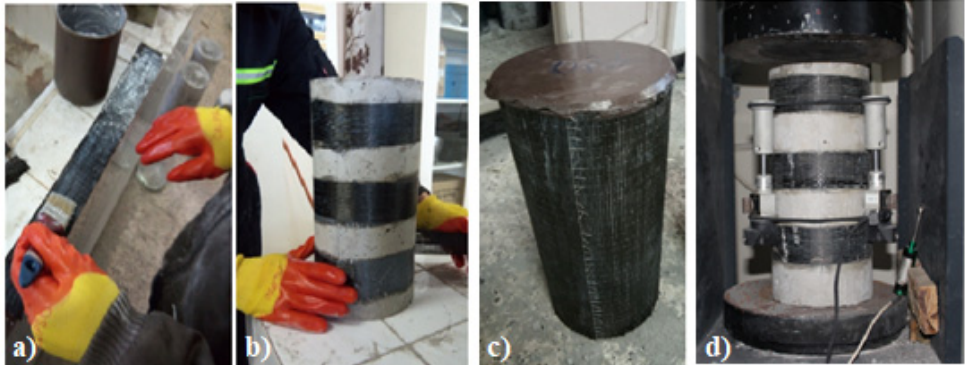
Figure 3. ( a ) Epoxy adhesive application; ( b ) specimens wrapping; ( c ) capping of concrete cylinders; and ( d ) test instrumentations.